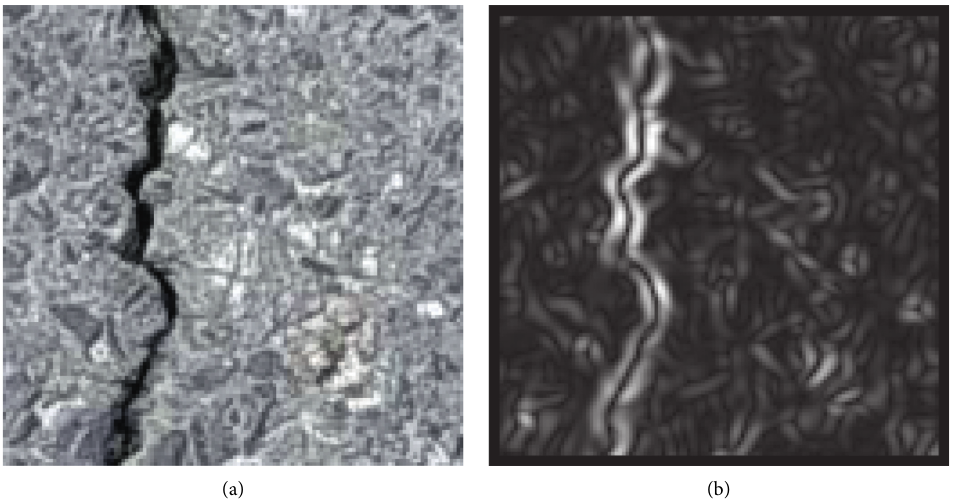
Figure 3: Illustration of the GSF. (a) Input image. (b) Output image.